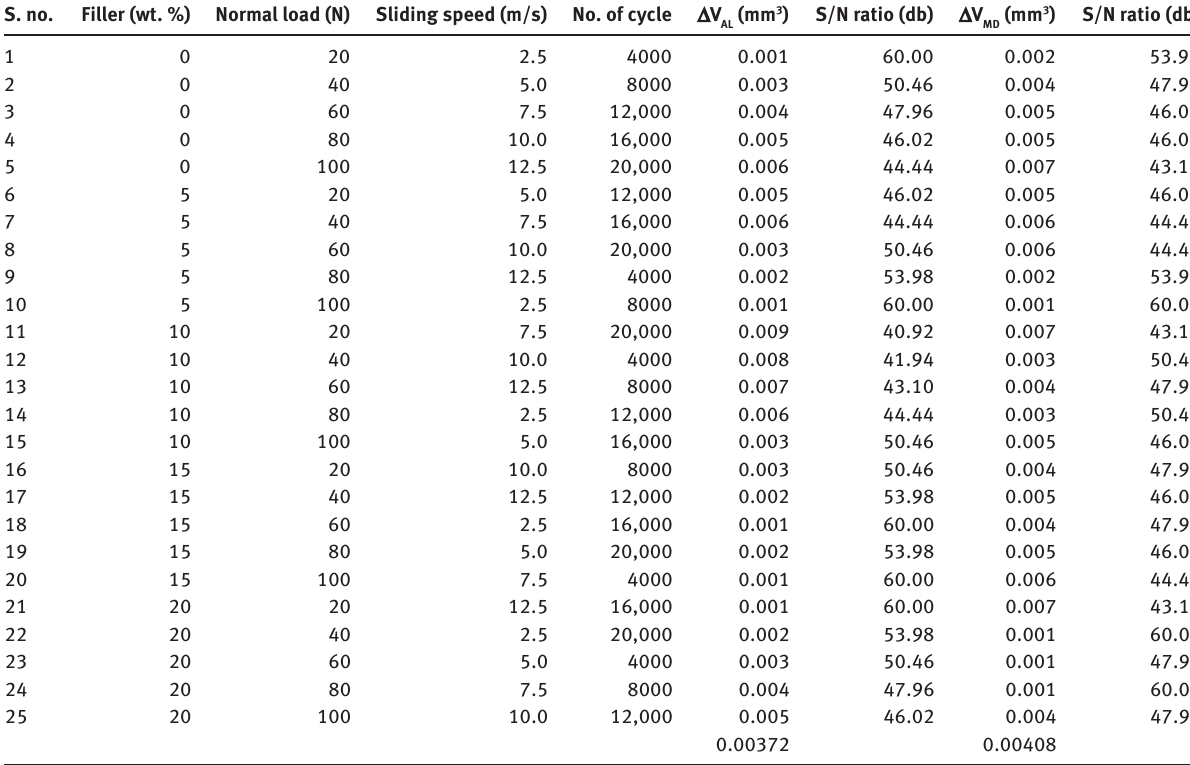
orthogonal array. 25